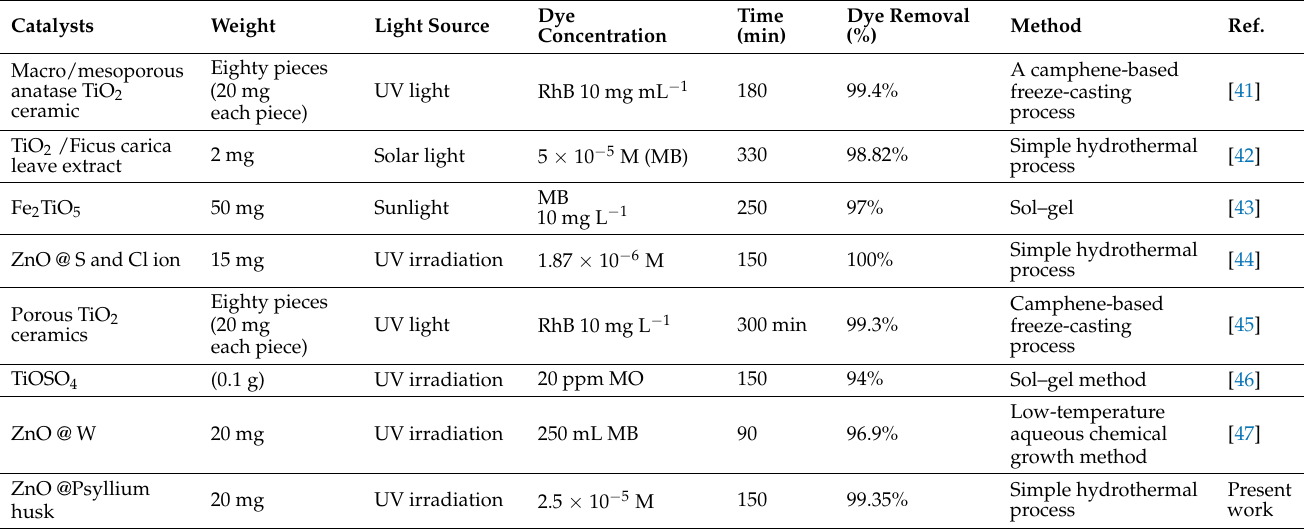
Table 3. The comparative analysis of present work with published